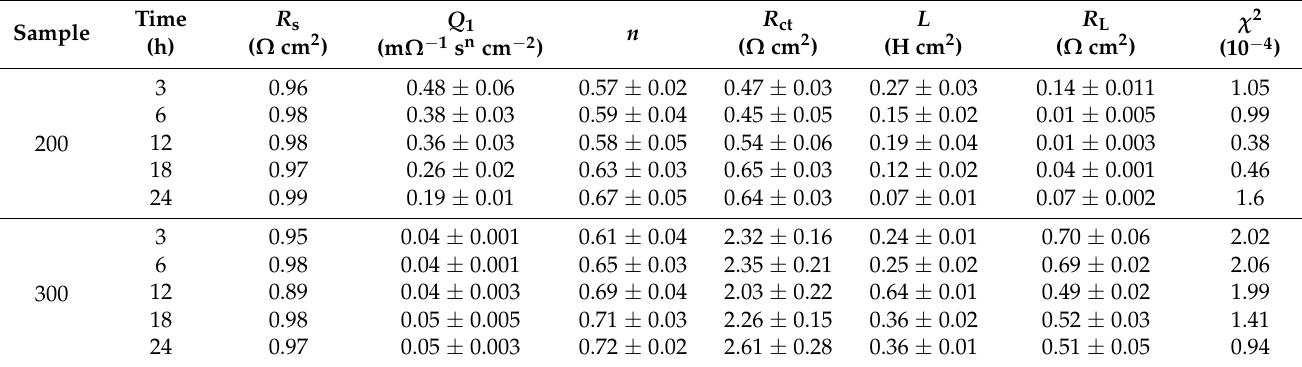
Figure 4. Equivalent circuit used to fit the EIS plots. Here, R s is the electrolyte resistance, Q d l is the constant phase element representing the double charge layer capacitance and R ct is the charge transfer resistance. L and R L represent the inductance and inductance resistance, respectively.